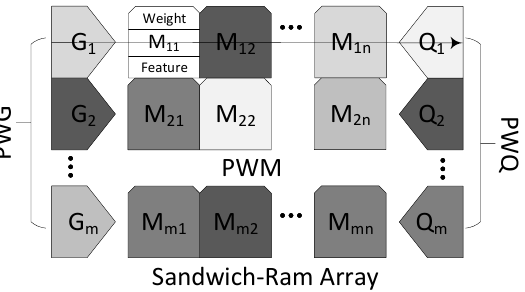
Figure 2. Sandwich-Ram array for matrix multiplication. The array combines Pulse-width Generator (PWG), Pulse-Width Modulator (PWM) and Pulse-Width Quantizer (PWQ). Each PWM has a local feature and